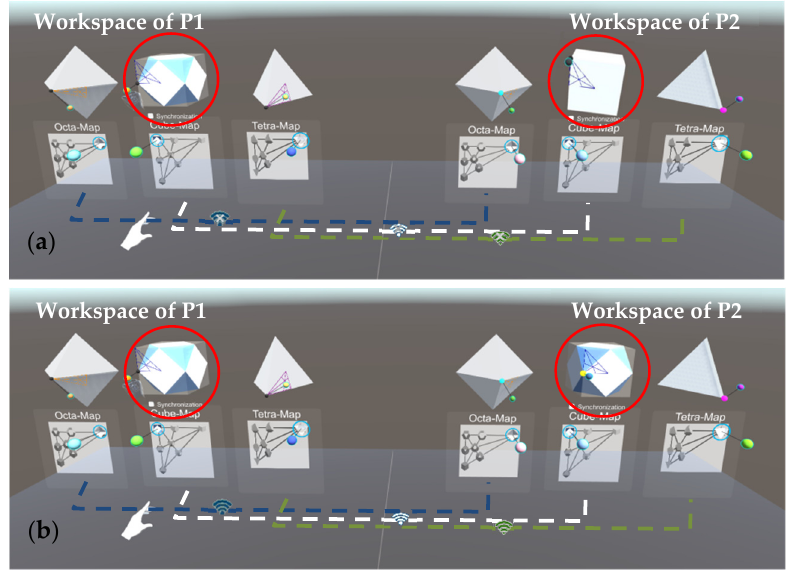
Figure 4. Different two modes of interaction. ( a ) Interaction in the Non-Shared version (asynchronous change in two applications). ( b ) Interaction in the Shared version (synchronous change in two applications).